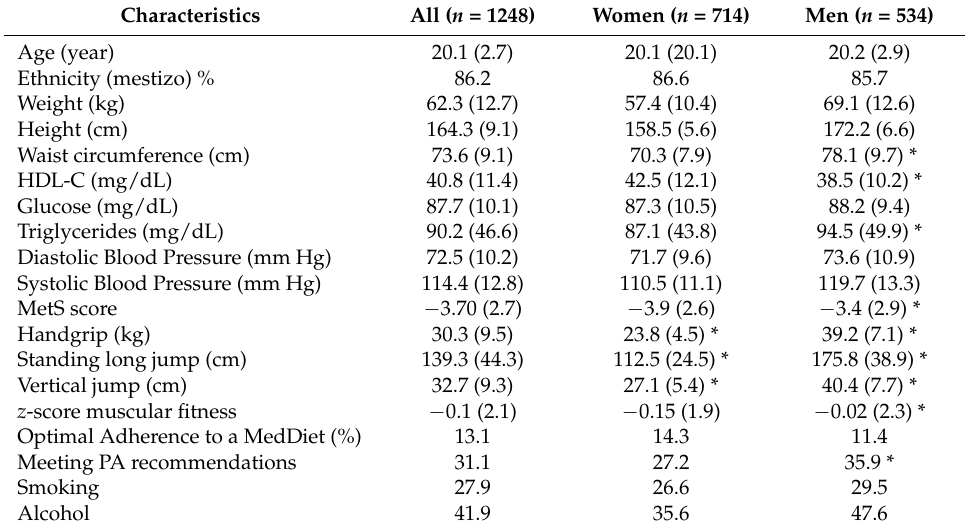
Table 1. Characteristics among a sample of college students from Colombia (mean (SD) or frequency